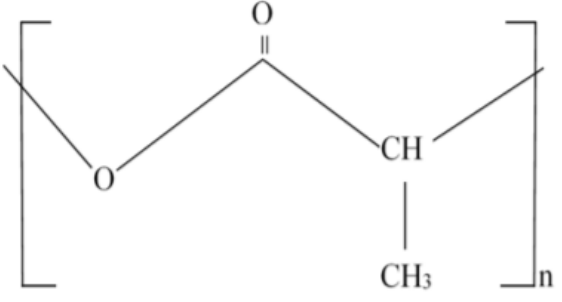
Figure 1. Chemical Structure of Polylactide Acid .